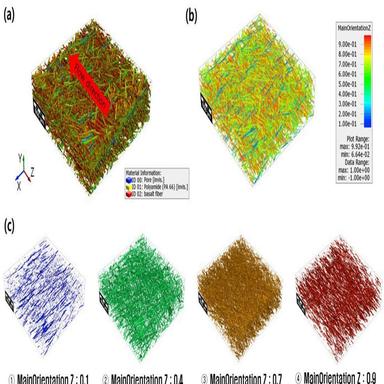
Internal microstructural characterization of the fiber orientation distribution in the SBF/PA6,6 composites. (a) Orientation distribution of individual fibers distinguished by a color code; (b) overlay image to verify the fiber orientation distribution inside; and (c) color images extracted for individual fibers with Main-Orientation Z of 0.1, 0.4, 0.7, and 0.9. (For interpretation of the references to color in this figure legend, the reader is referred to the Web version of this article.)